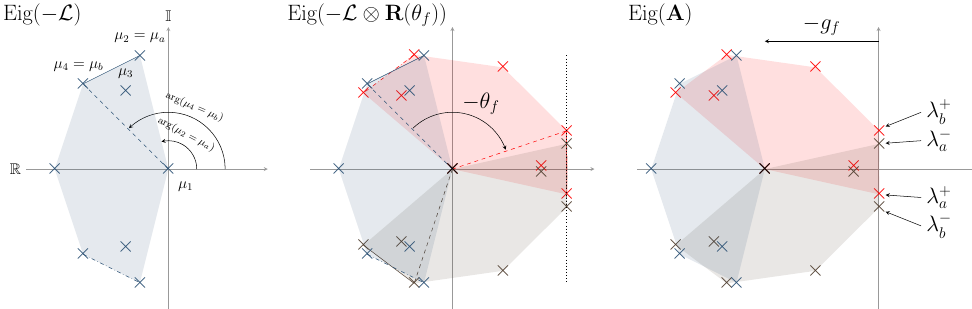
Figure 2. Evolution of the eigenvalues’ repartition while building the